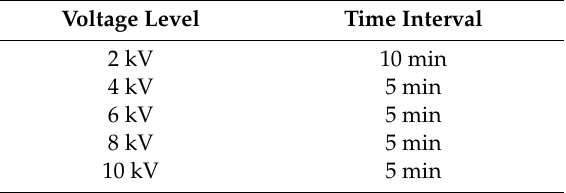
Table 1. The voltage levels and time sequence used in the Step Voltage Measurement (SVM) tests.